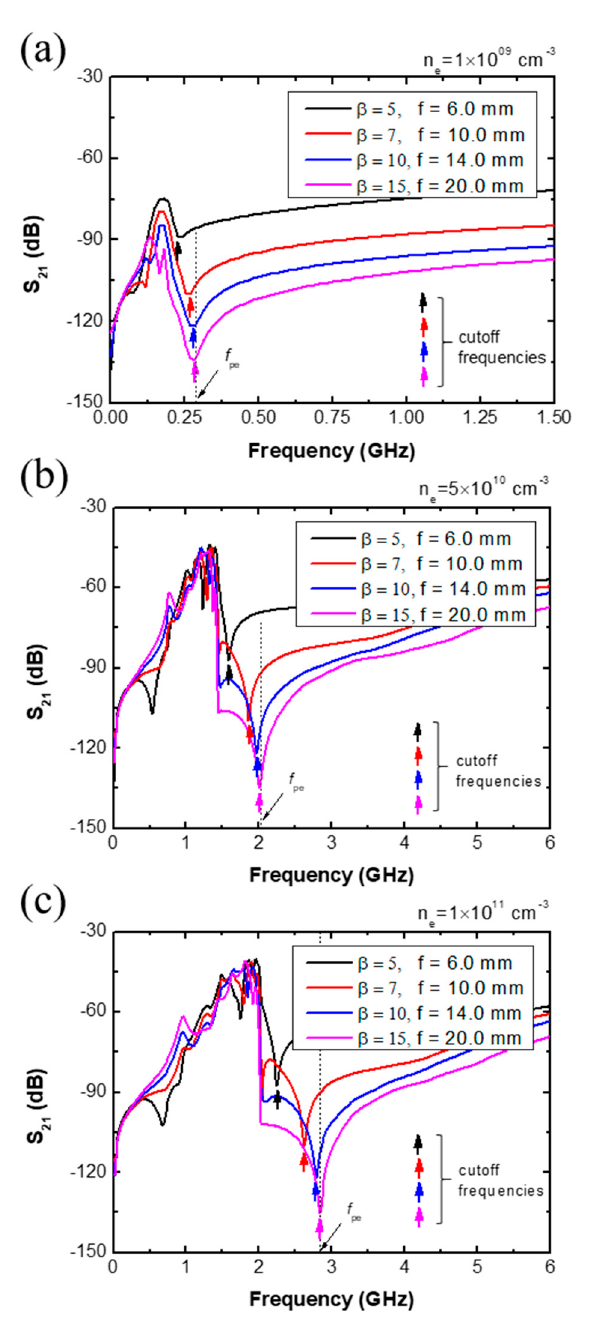
Figure 6. S 21 spectra of the BCP from various normalized antenna distances ( β ) with electron densities of ( a ) n e = 1 × 10 9 cm − 3 , ( b ) 5 × 10 10 cm − 3 , and ( c ) 1 × 10 11 cm − 3 .